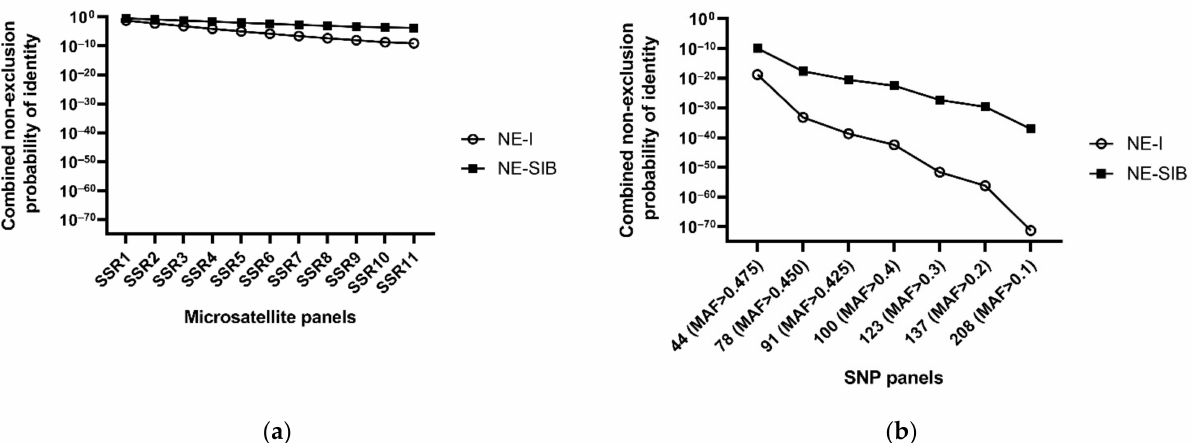
Figure 1. Combined non-exclusion probability for identity based on microsatellites ( a ) or SNPs ( b ). NE-I refers to the combined non-exclusion probability for identity of unrelated individual pairs, NE-SIB refers to the combined non-exclusion probability for identity of full-sibling